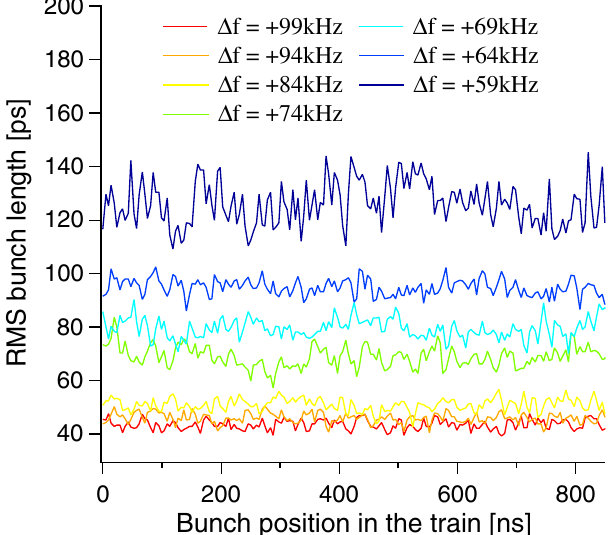
FIG. 11. (Color) rms bunch length along the bunch train for several 3HC tuning for uniform filling; I 2 : 0 GeV .